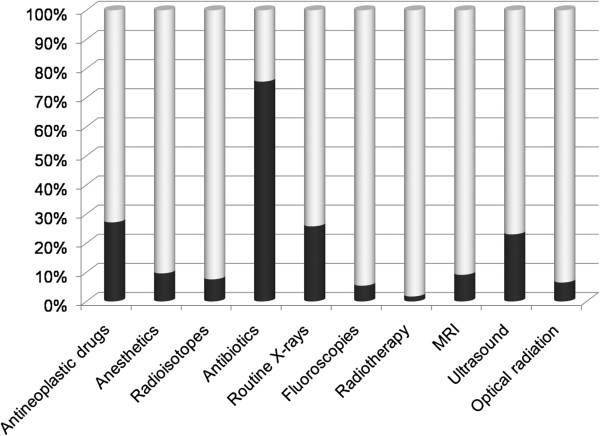
Frequency of self-reported other occupational exposures among 59,947 Nightingale Study participants. Legend: Dark part of bar indicates the proportion of participants who answered ‘yes’ to the following question ‘Have you ever worked with …… regularly for at least 6 months?